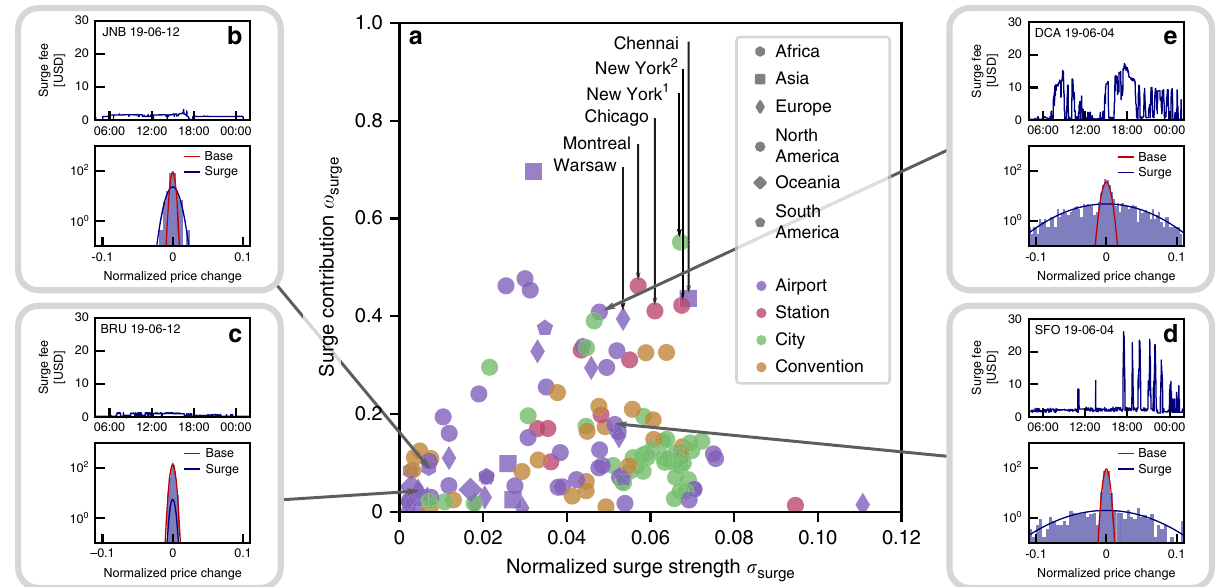
Fig. 3 Characterizing non-equilibrium surge dynamics. The timescales of price changes characterize the surge dynamics at different locations. These price changes separate into small, slow changes P base corresponding to varying base costs and fast, strong changes P surge corresponding to the surge fee (red and blue line in the histograms in b – e , respectively). a Characterizing locations by the total weight w surge of the surge component of the price change distribution and the magnitude σ surge of the associated price changes reveals several locations [e.g., Warsaw, Montreal, Chicago, New York City [city(1) and station(2)] and Chennai] with similar surge characteristics to DCA (see Fig. 4 and “ Methods ” section and Supplementary Note 2 for more details and additional examples). b and c (left), Locations with low surge strength σ surge exhibit no signi fi cant surge activity and no price changes on a fast time scale, shown here for Johannesburg (JNB, South Africa) and Brussels (BRU, Belgium). d (bottom right), Locations with high surge strength σ surge and small surge contribution w surge exhibit relatively few price surges (SFO, San Francisco, USA). e (top right), Locations with high surge strength σ surge and high surge contribution w surge exhibit a large number of fast price surges potentially driven by arti fi cially induced supply shortages. Figure 4 con fi rms that the surge fee dynamics at these locations is indeed similar to the dynamics observed at DCA (Washington, DC,